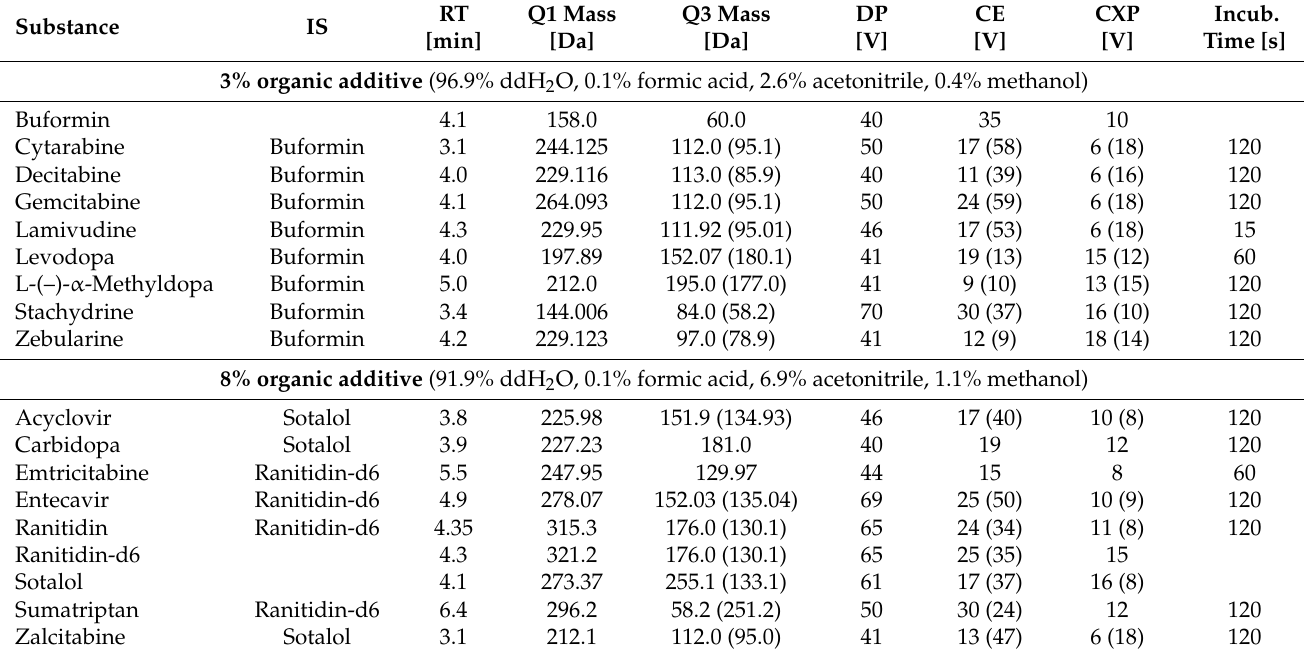
Table 1. HPLC, detection and transport assay parameters.